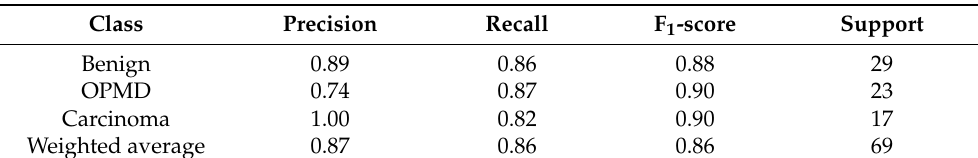
Figure 5. Confusion matrix for the EfficientNet-b4 model on the test set. The values on the diago- nal axis show the number of TP and TN predictions and the off-diagonal values show the number of FP and FN predictions, respectively, for each class. Table 7. Class-wise precision, recall, and F1-score results for the test set with the EfficientNet-b4 model.